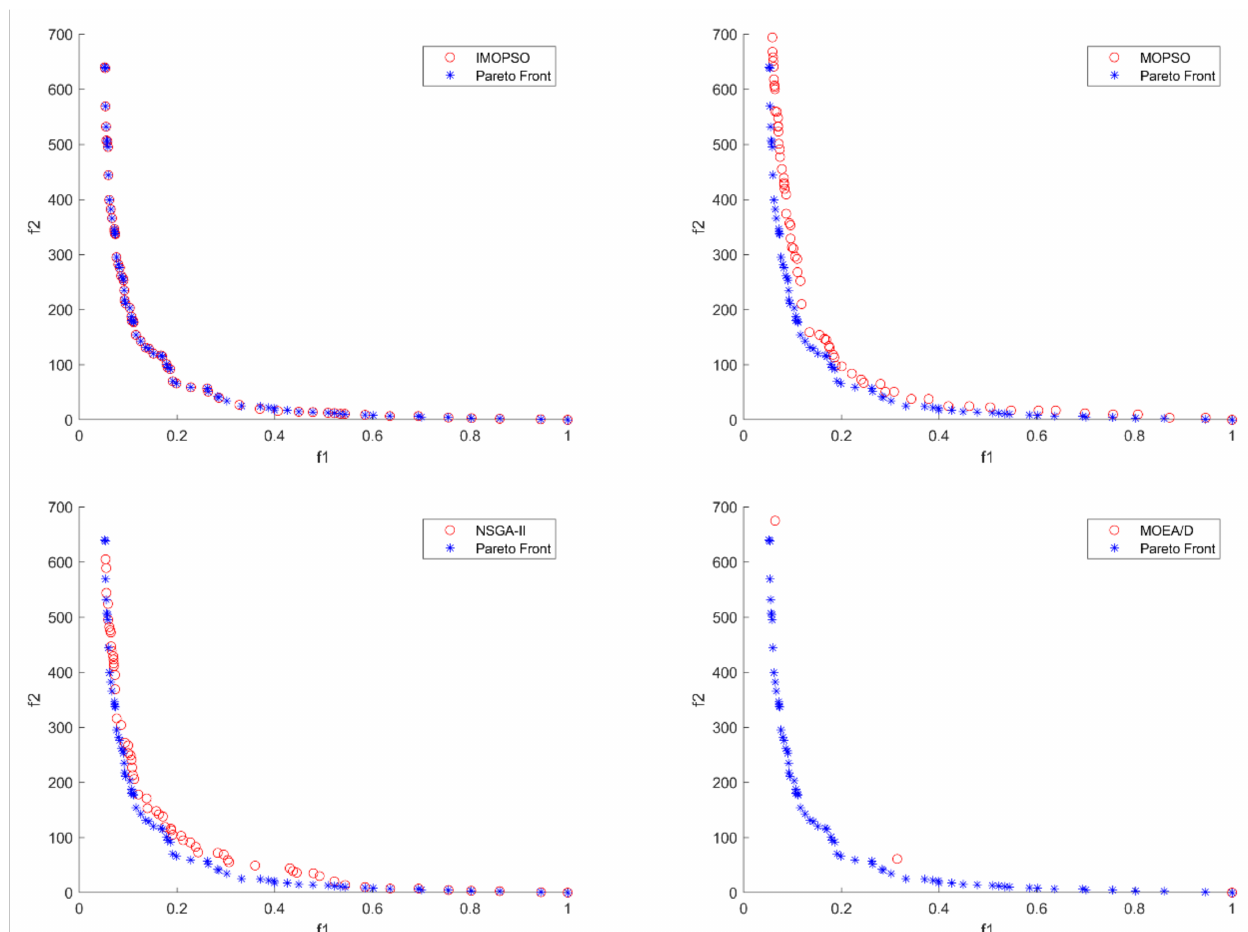
Figure 17. Pareto front produced by four algorithms on large-scaled